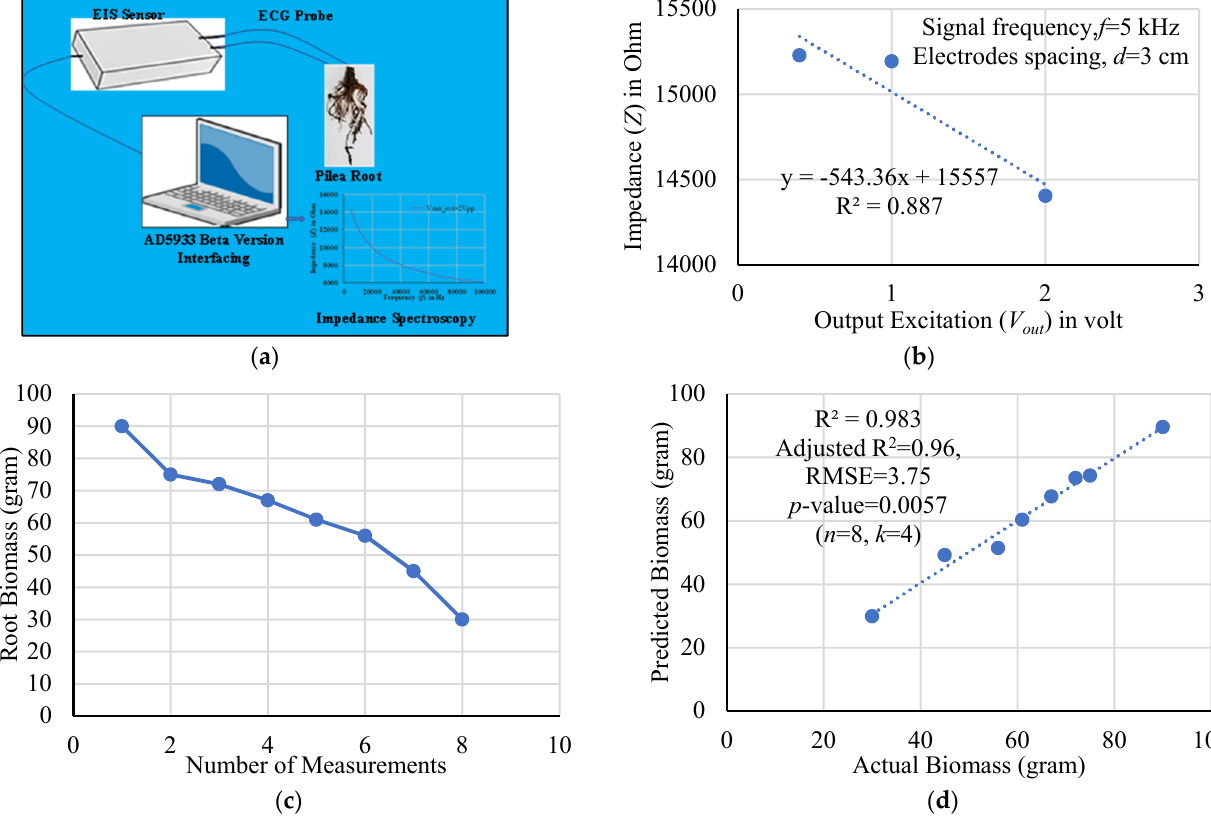
Figure 21. ( a ) EIS measurement of a Pilea root using AD5933EBZ, and ( b ) the corresponding correlation with output excitation. ( c ) Day-wise the biomass of the root was decreased for different measurements, and the corresponding impedance was increased. ( d ) A good correlation with R 2 = 0.983 and RMSE of 3.75 was obtained by the predicted model at 5–7 kHz considering 2 Vpp excitation.